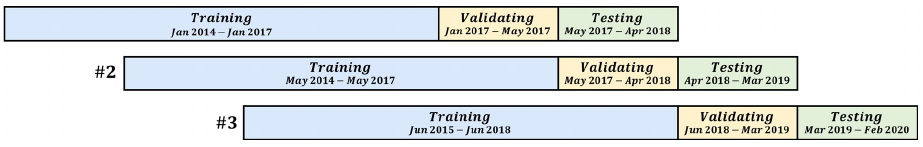
Figure 4. Training, validating, and testing